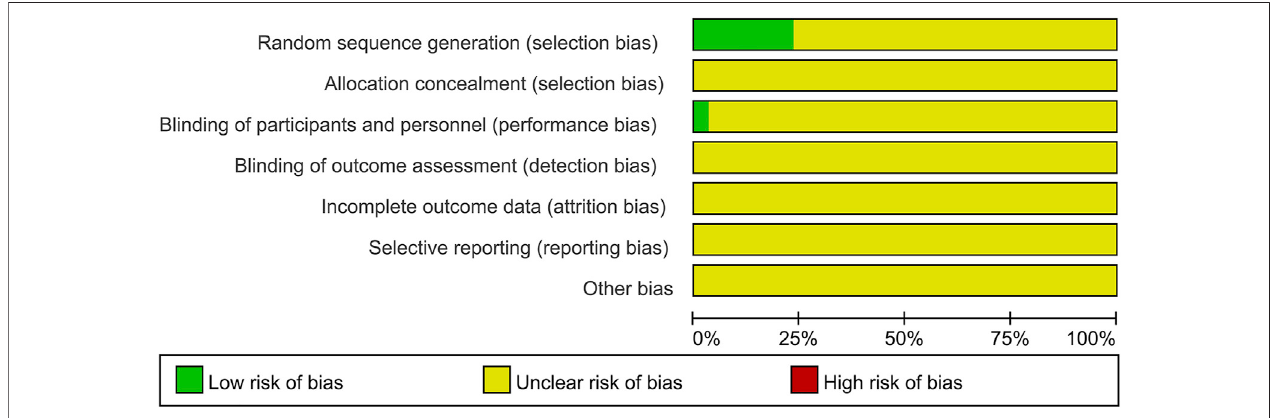
FIGURE 3 | Network of comparisons for ef fi cacy. The size of the circle shows the number of each randomized controlled trial included. The width of thelinesisproportionaltothecomparisonsofeachrandomizedcontrolledtrial included. Notes: (A) UDCA, (B) Yinzhihuang oral liquid + UDCA, (C) salvia injection + UDCA; (D) Yinchenhao decoction + UDCA, (E) the similar prescriptionofYinchenhaodecoction 1+UDCA, (F) thesimilar prescription of Yinchenhao decoction 2 + UDCA, (G) the similar prescription of Yinchenhao decoction3+UDCA, and (H) othertraditional Chinesemedicineprescriptions + UDCA. UDCA, ursodeoxycholic